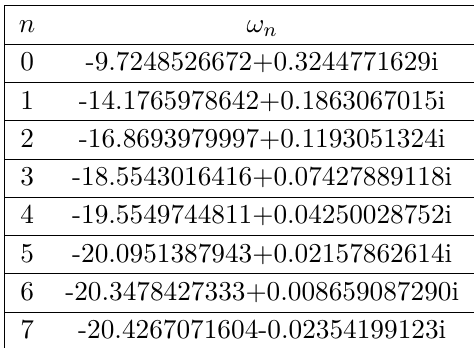
Table 2 . Quasinormal modes of scalar perturbation for Q = 3 . 4 and q = 6 . There are multiple unstable modes in the spectrum.